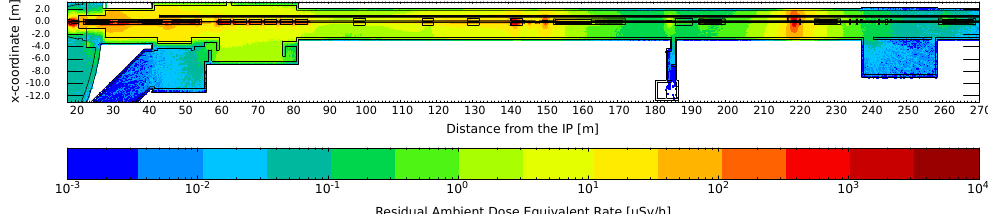
Figure 1. Projected radiation levels expected at LHC LSS1 at the end of Run 3 proton-proton physics: 4 months cool down.